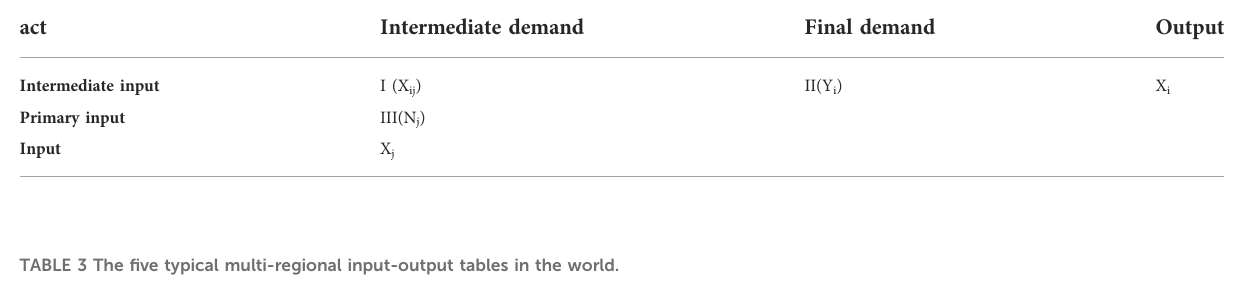
TABLE 2 The basic pattern of the input-output table.